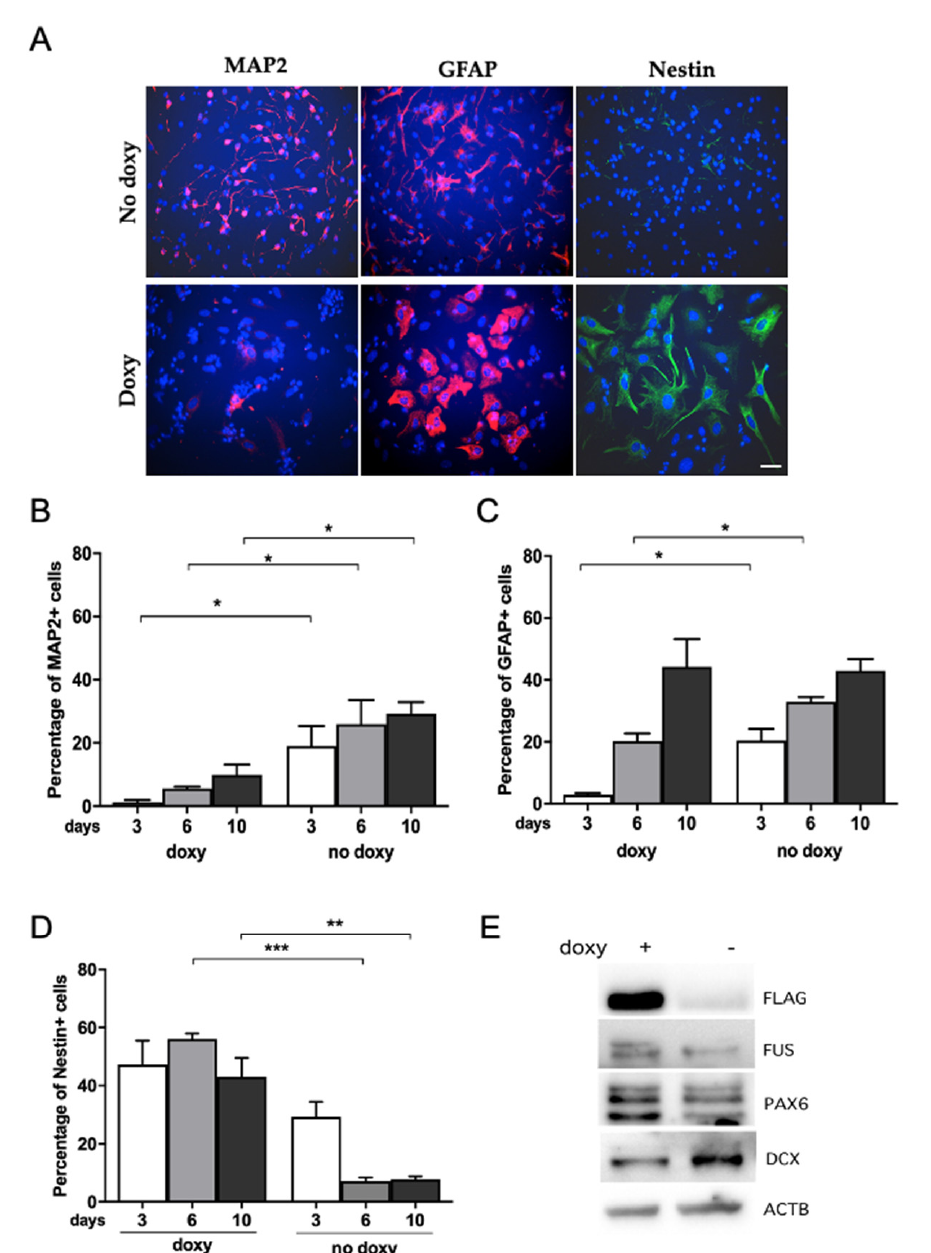
Figure 3. hWT-FUS expression reduces neuronal differentiation. ( A ) Representative images of NSPCs maintained in neuronal differentiation medium (DAPT 0.5 nM) for 3, 6, and10 days and then fixed and stained for the neural marker Nestin, the glial marker GFAP and the neuronal marker MAP2. Scale bar 30 µ m. ( B – D ) Percentage of cells positive for MAP2 ( B ), GFAP ( C ) and Nestin ( D ) at the analyzed time points. ( E ) Representative immunoblot of the indicated proteins in NSPCs differentiated for 6 days. Note an increase in PAX6 level and a decreased level of the immature neuronal marker DCX with respect to doxycycline-untreated cells. Beta-actin is used as a loading control. Data are shown as mean ± SEM of three independent experiments. Mann–Whitney test * p < 0.05 ** p < 0.01 *** p < 0.001.